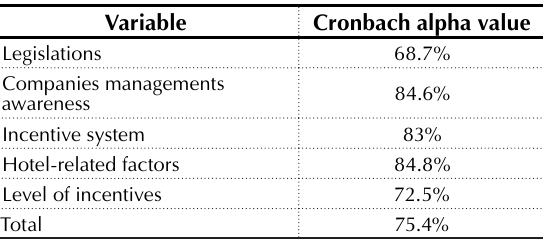
Table 1. Authenticity and reliability of this study